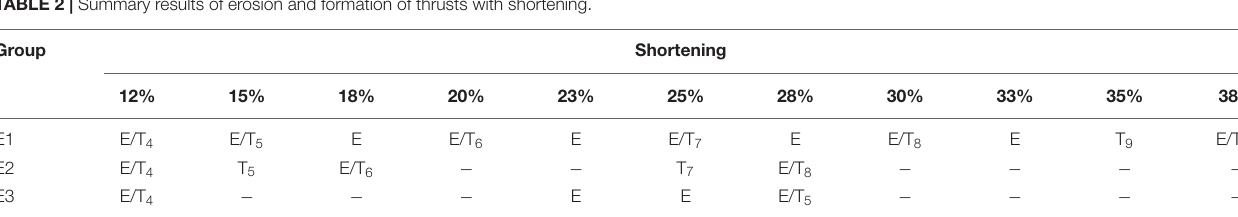
TABLE 2 | Summary results of erosion and formation of thrusts with shortening. Group